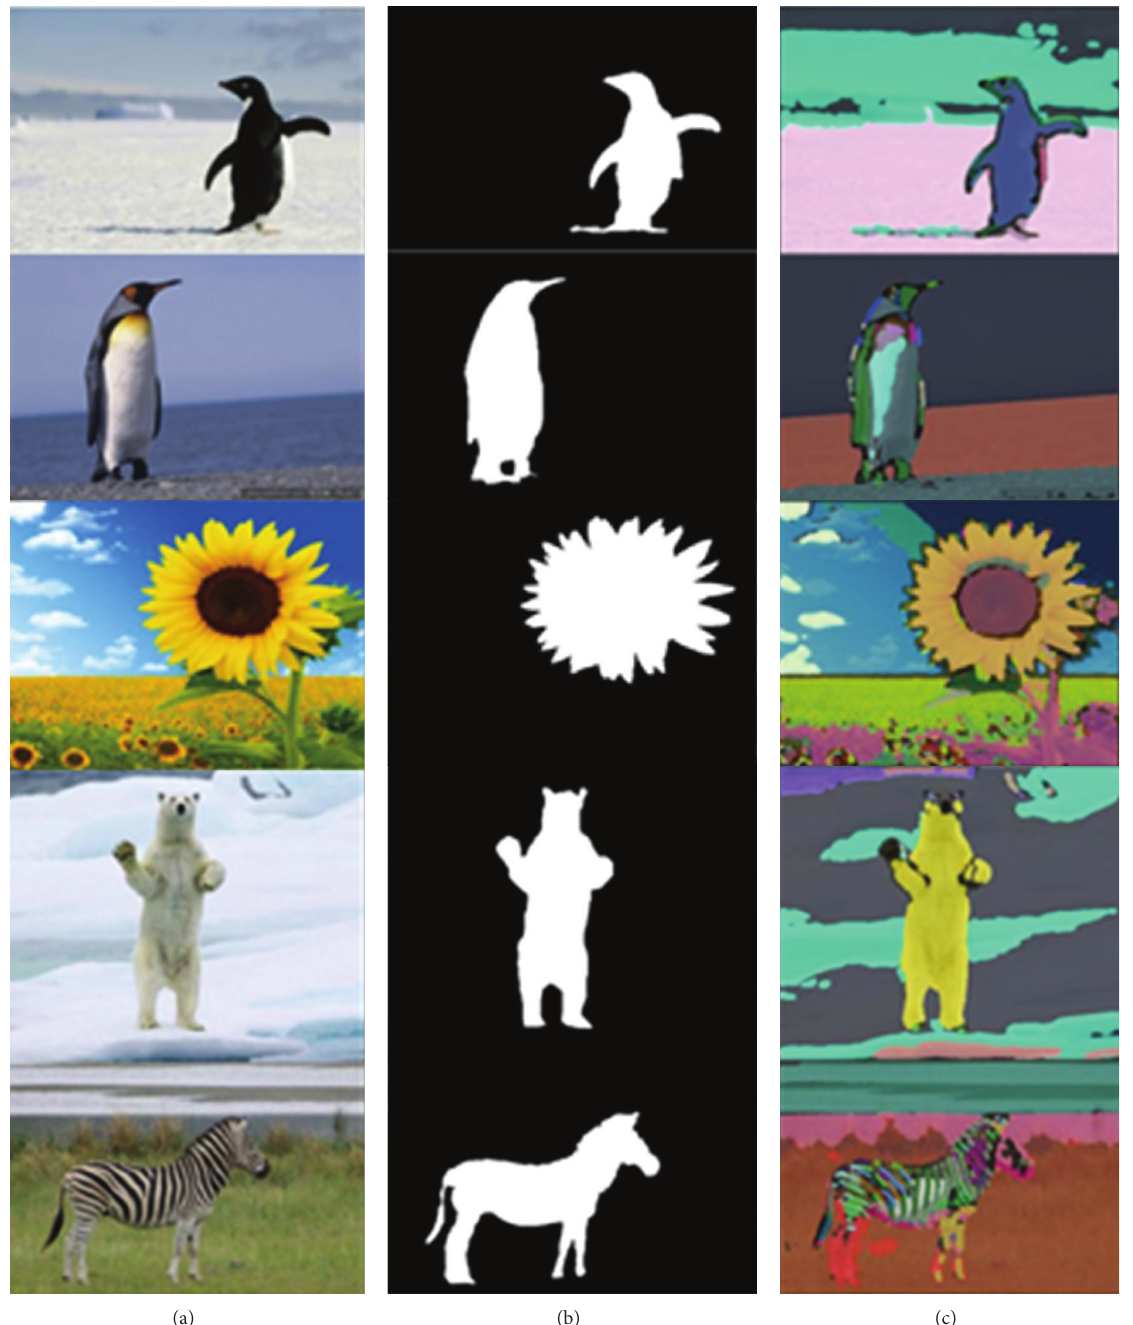
Figure 6: Saliency and PatchNet appearance map: original image (a), mask (b), and PatchNet appearance map (c).